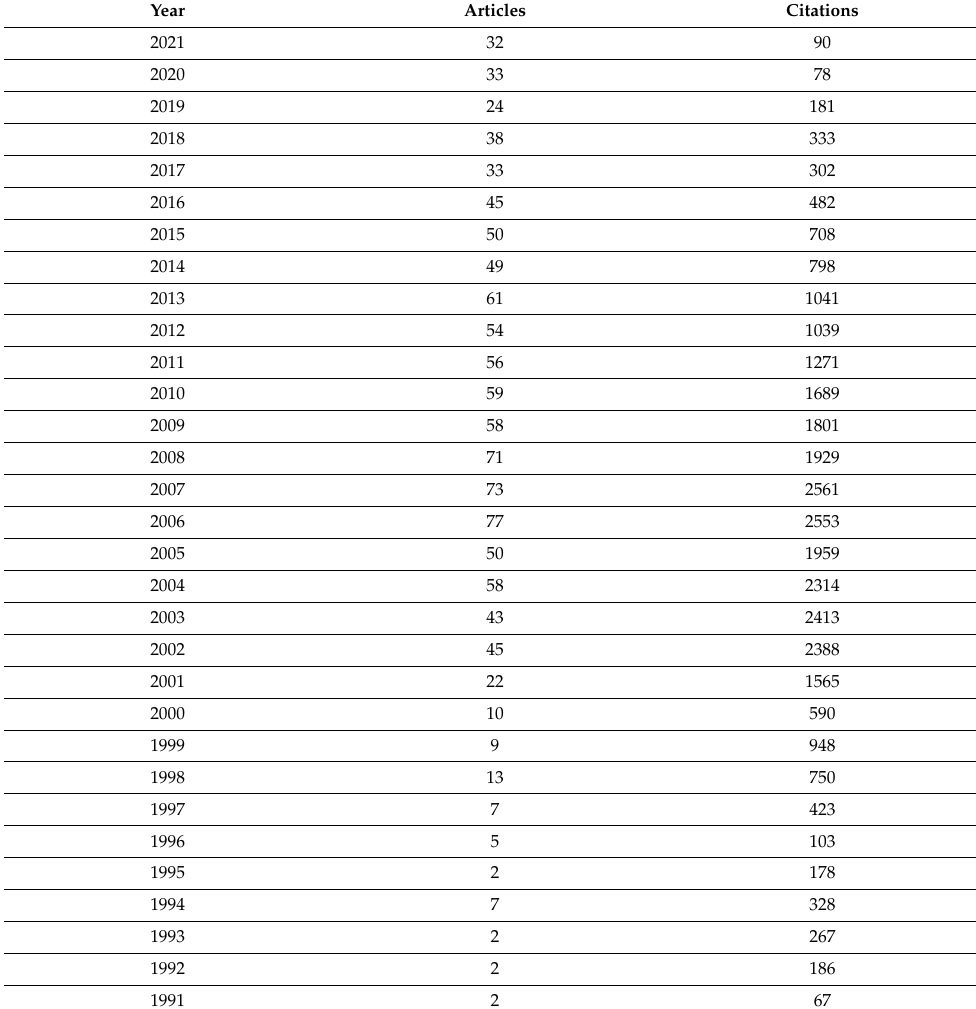
Figure 2. Yearly anthrax vaccine articles published from 1991 to 2021. Table 2. Number published articles and citations in anthrax vaccine per year from 1991 to